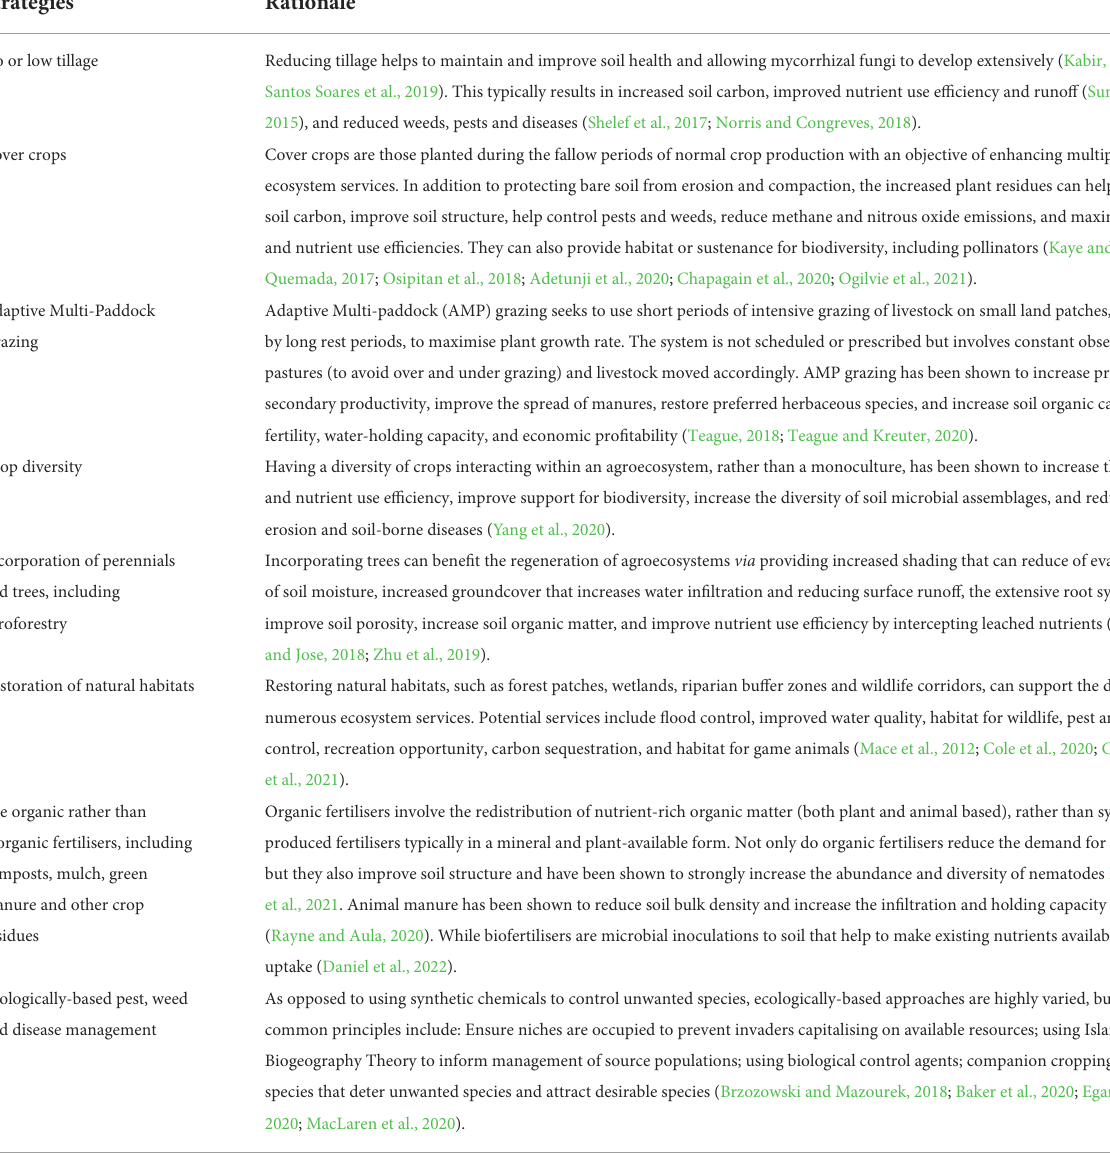
TABLE 1 Agricultural strategies commonly used in regenerating agroecosystems (LaCanne and Lundgren, 2018).